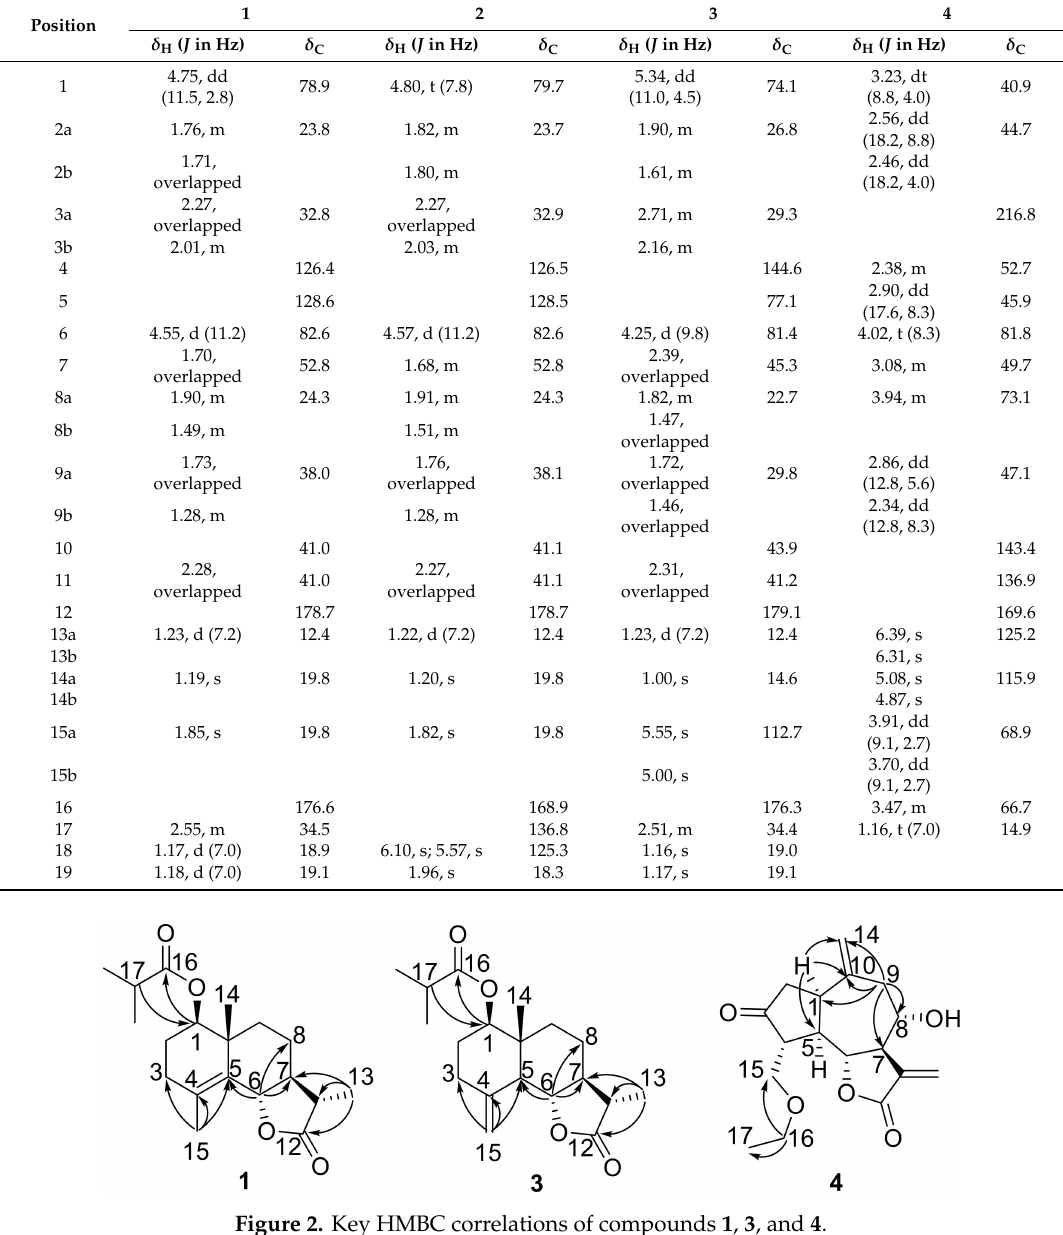
Table 1. 1 H NMR (600 MHz) and 13 C NMR (150 MHz) spectroscopic data for compounds 1 – 4 in CDCl 3 .